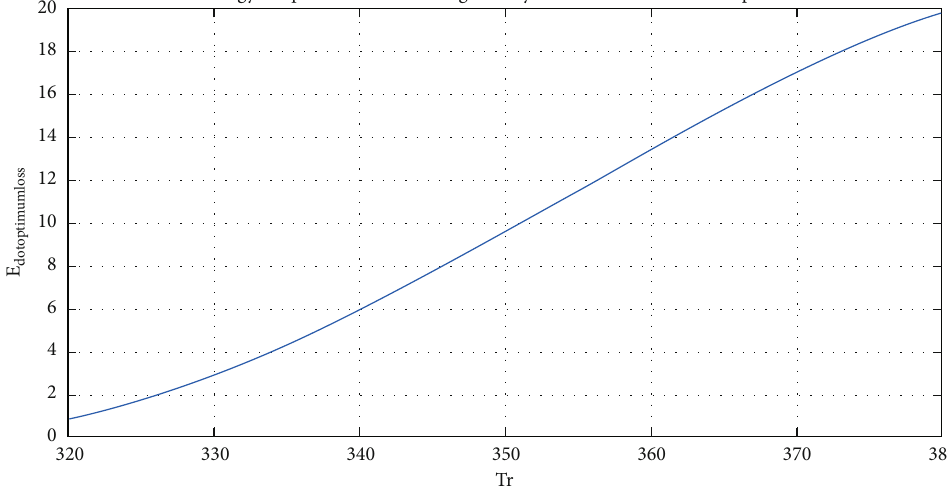
Figure 9: Changes of optimal loss of exergy by absorber pipe receiver